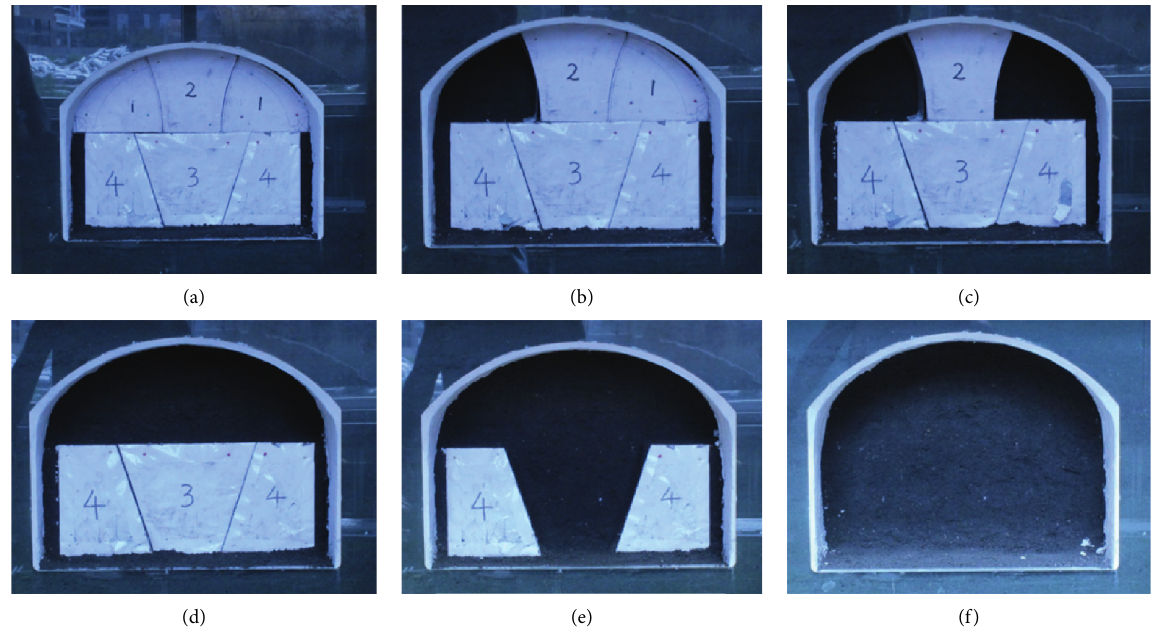
Figure 12: Excavation sequence sketch of the arch-cover method. (a) Initial excavation face. (b) Area 1 left excavated. (c) Area 1 right excavated. (d) Area 2 excavated. (e) Area 3 excavated. (f) Area 4 excavated.